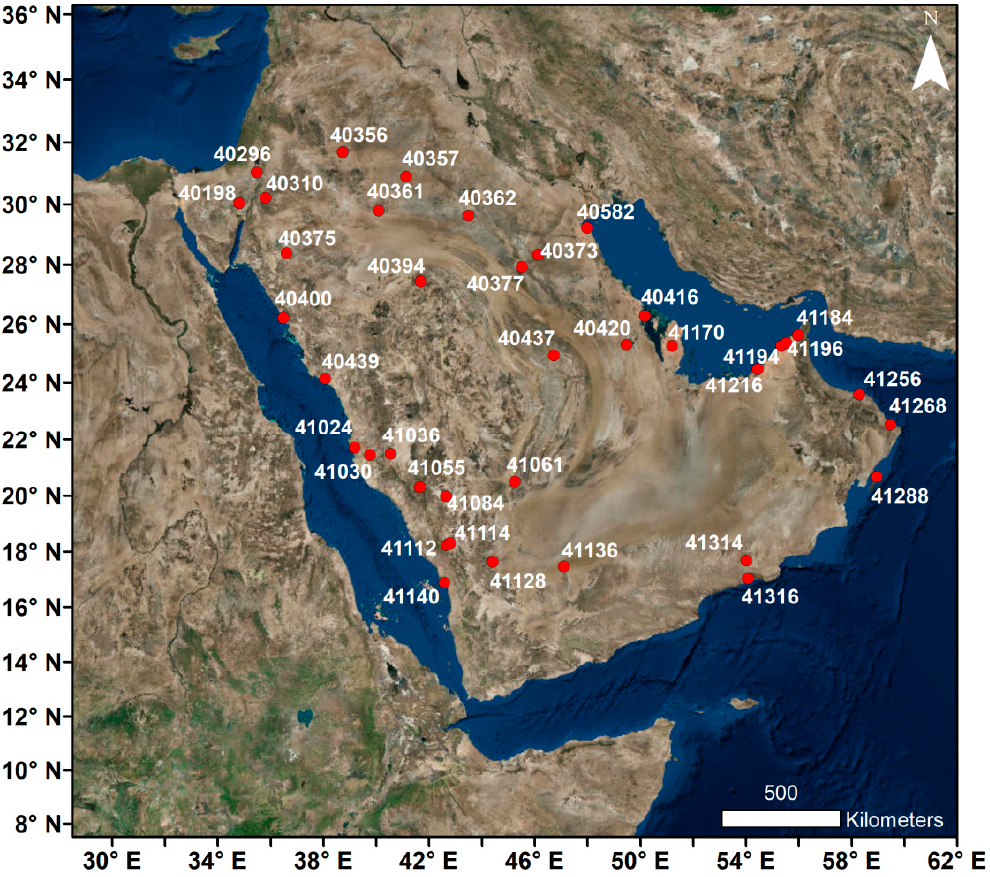
Figure 1. The model domain displayed as a topographical chart of the Arabian Peninsula. The locations and the codenames of the stations used for the evaluation study are also depicted.